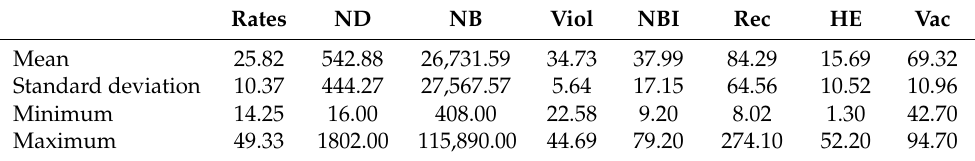
Table 1. Descriptive statistics for the variables available in the study of infant mortality in Colombia. Rates ND